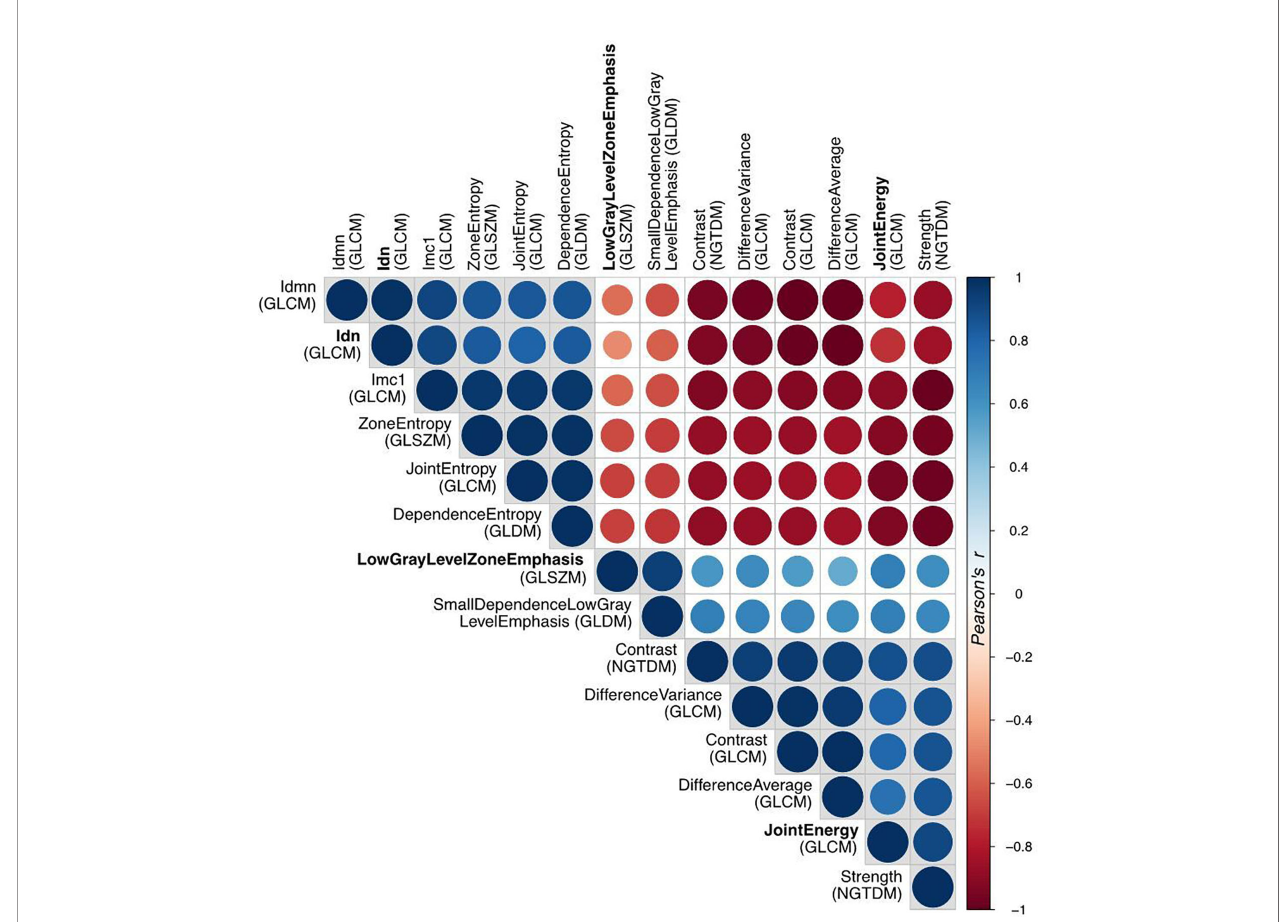
FIGURE 5 | Correlation matrix of all the radiomic features with high signi fi cance (p<0.0002) in t-test for patient response. The Pearson ’ s correlation coef fi cient identi fi es three disjointed clusters, in which the three representatives (Idn=InverseDifferenceNormalized, JointEnergy and LowGrayLevelZoneEmphasis) are highlighted in